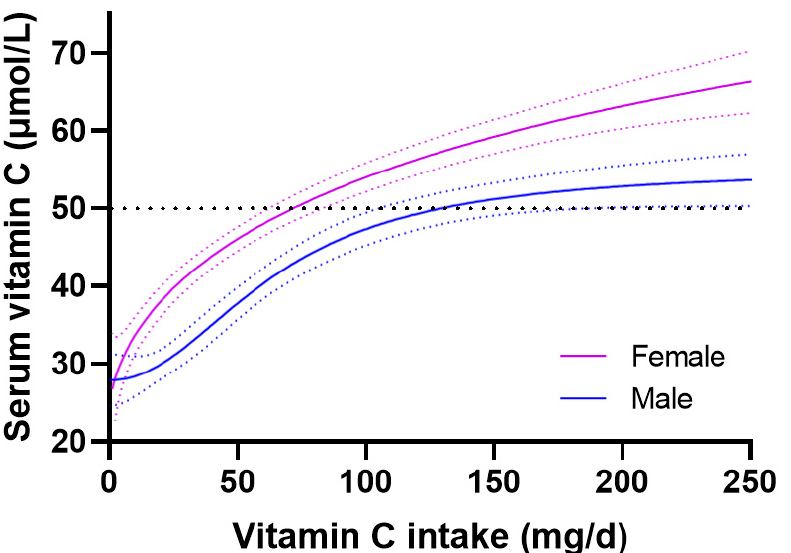
Figure 2. Vitamin C dose-concentration relationship relative to gender. Female n = 1403; male n = 1425. Sigmoidal (four parameter logistic) curves were fitted to the dose-concentration data with asymmetrical 95% confidence intervals indicated. Dashed line indicates 50 µmol/L serum vitamin C, which is considered ‘adequate’.